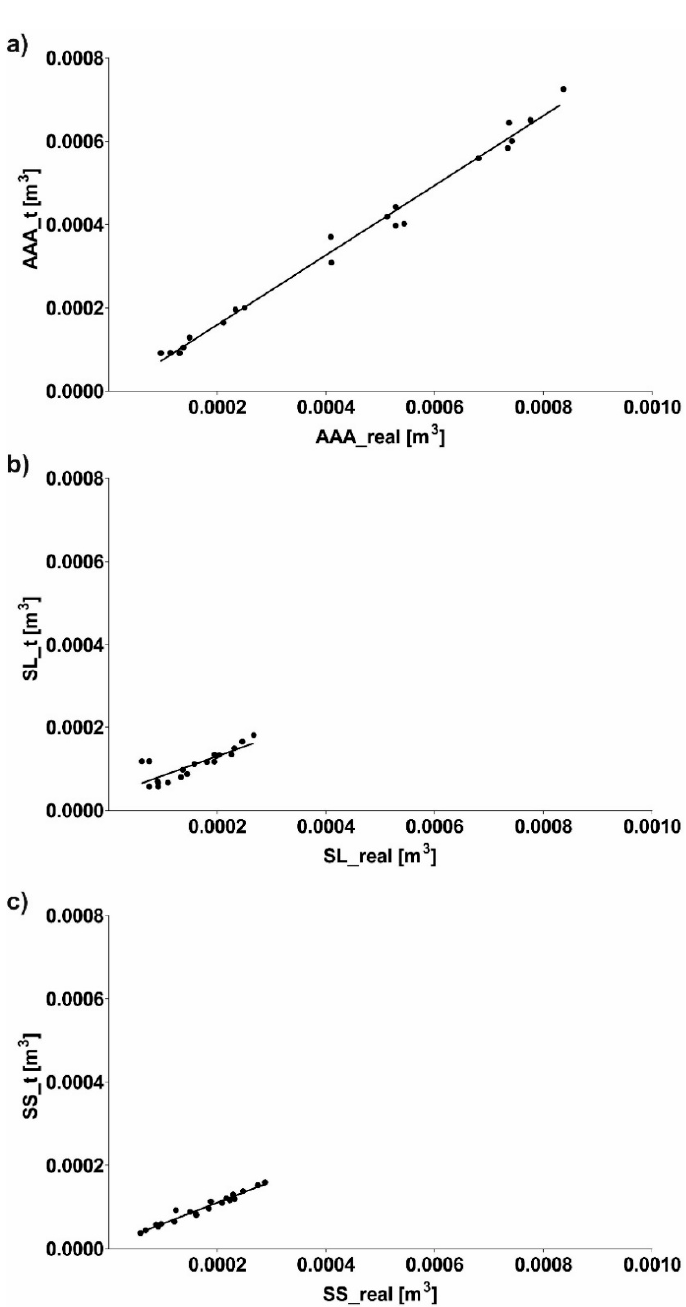
Figure 4. Scatterplot graphic representation of Pearson’s correlation factors rho [-] for the analyzed real geometry of ( a ) AAA in function of reference cylinder (rho = 0.9947), ( b ) SL in function of reference cylinder (rho = 0.8252), ( c ) SS in function of reference cylinder (rho = 0.9801). For all analyzes p < 0.001.